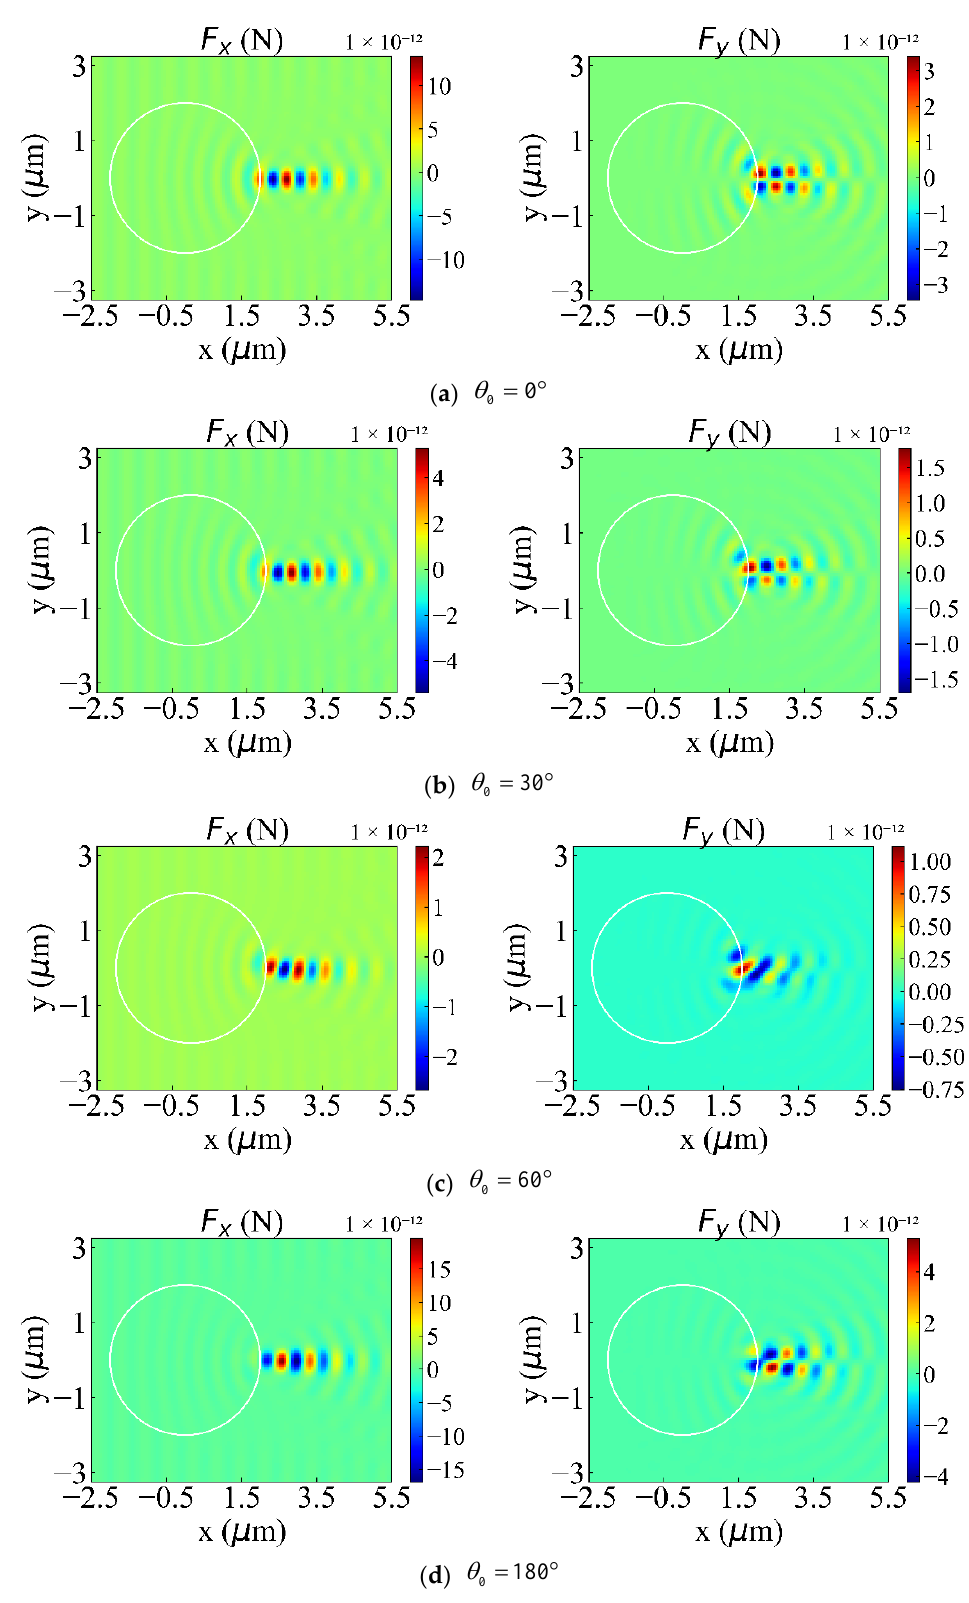
Figure 9. Optical force exerted on a nanorod with different θ 0 . Panels ( a – d ) show the optical forces F x and F y when θ 0 = 0 ◦ , 30 ◦ , 60 ◦ , and 180 ◦ , respectively.